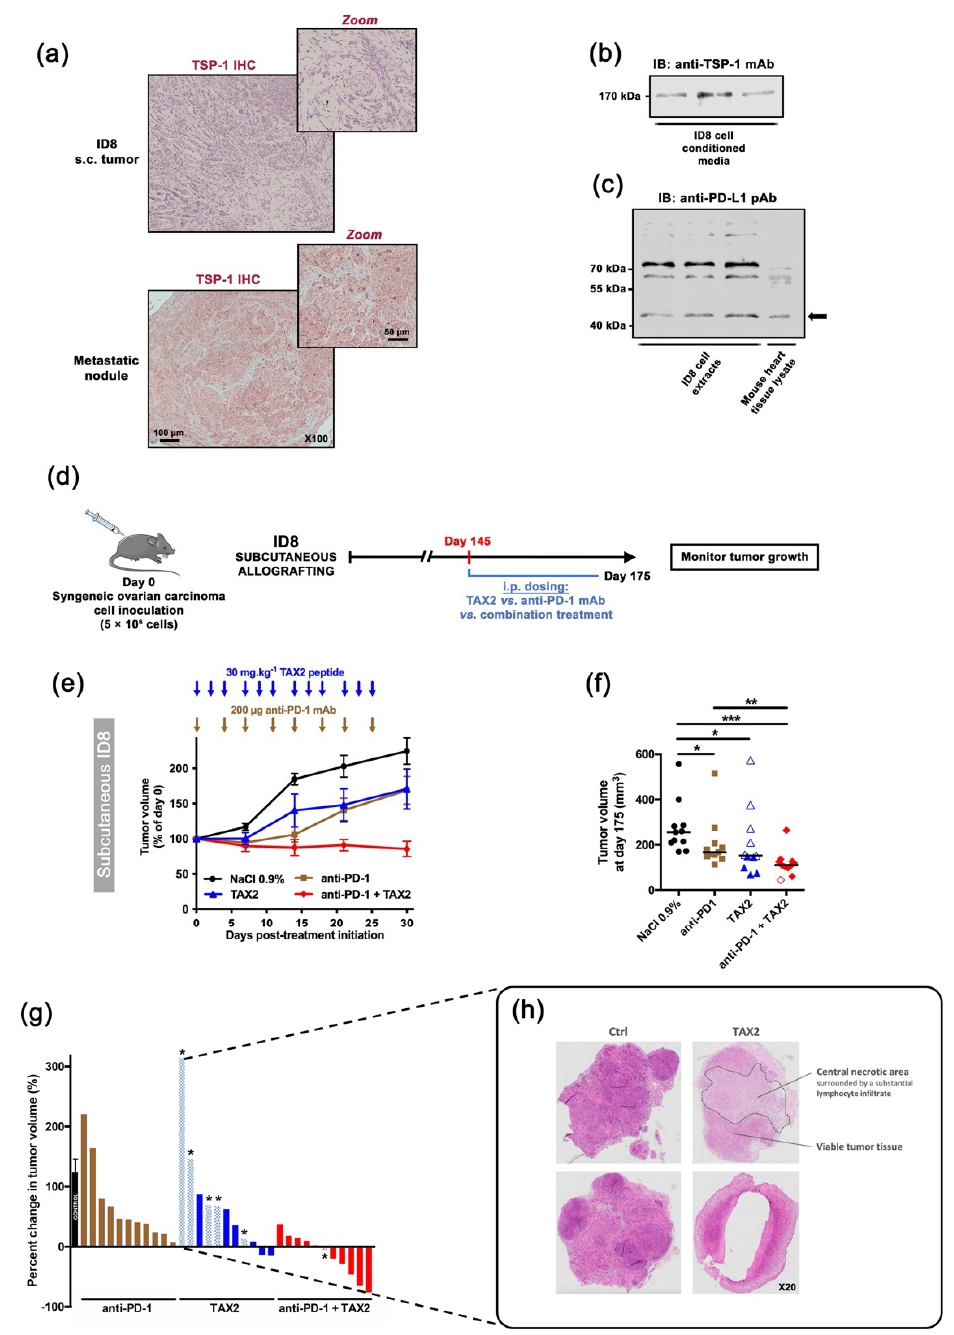
Figure 5. Therapeutic evaluation in subcutaneous syngeneic ID8 ovarian carcinoma allografts: TAX2 monotherapy and combination with anti-PD-1 mAb. ( a–c ) Characterization of the ID8 mouse ovarian epithelial cell line. ( a ) ID8 inoculation in C57BL/6 mice may result in s.c. (left panel) or peritoneal (right panel) tumor formation, in both of which ID8 tumor cells express TSP-1 (i.e., TAX2 peptide direct molecular target) in large amount, as revealed by immunohistochemistry. ( b , c ) Western blot analyses confirmed that ID8 cells ( b ) release TSP-1 in the extracellular medium when maintained in culture, while ( c ) they also express the PD-L1 protein at their cell surface (arrow). The corresponding uncropped immunoblots were presented in Supplementary Materials Figure S1. ( d–g ) 5 × 10 6 ID8 cells were s.c. implanted in C57BL/6JRj mice in order to recapitulate subcutaneous tumor formation ( d ). On day 145 (i.e., when mean tumor volume reached 100–200 mm 3 ), mice were randomized (n = 11 per group) and then received the following treatments i.p.: 0.9% NaCl (100 µ L, thrice weekly, black circles), TAX2 peptide (30 mg · kg − 1 mouse weight, thrice weekly, blue triangles), anti-mouse PD-1 mAb (200 µ g, twice weekly, brown squares) and combined TAX2/anti-PD-1 therapy (red diamonds). Treatments lasted 4 weeks,